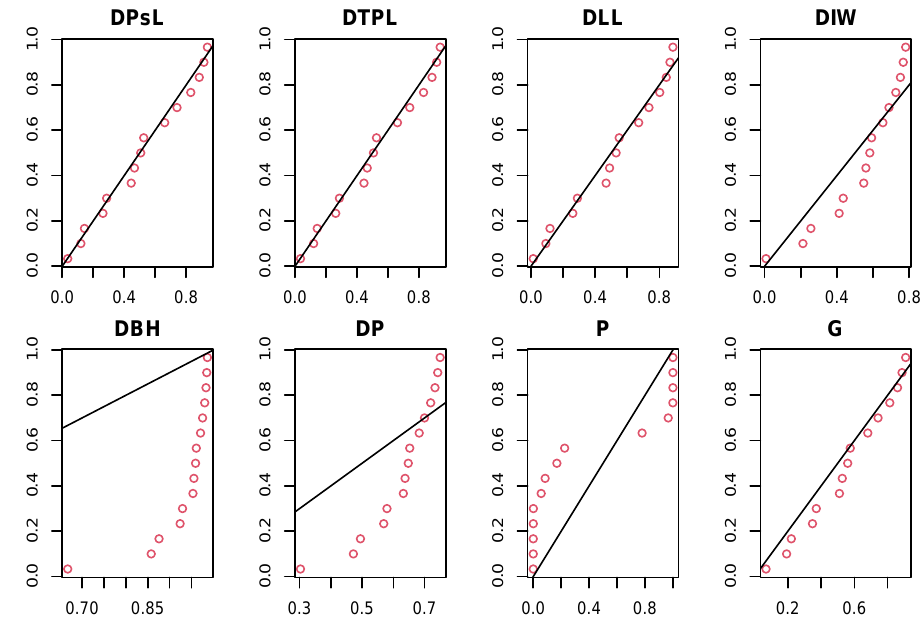
Figure 3. The P–P plots for the fitted distributions using the failure times data.